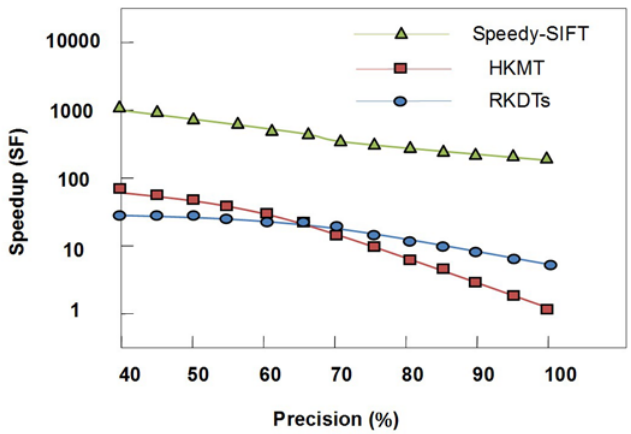
Fig 8. Trade-off between the matching speedup and matching